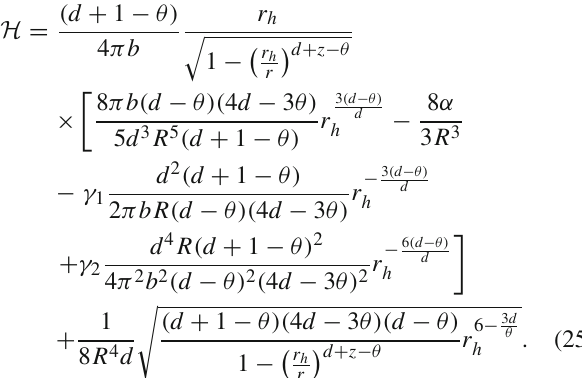
= 0 ( red solid ), α = 0, γ = 0 . 5 1 1